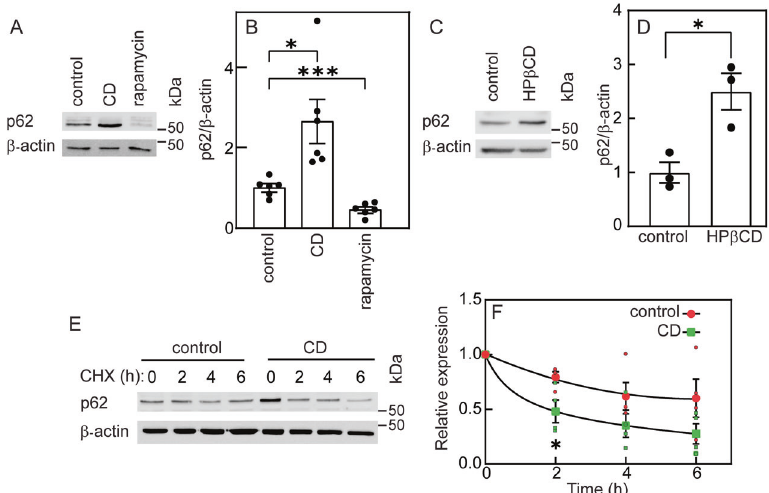
Fig. 4 p62 expression level is increased following cholesterol depletion. Mv1Lu cells were grown and treated (or not) by statin or by HP β CD to induce CD as in Fig. 3, or treated with rapamycin (150 nM, 16 h). They were then lysed and analyzed by immunoblotting for p62 and β -actin (loading control). A , C Representative blots of the effects of statin-mediated CD and of rapamycin ( A ), or of HP β CD-induced CD, on p62 levels ( C ). B , D Quanti fi cation of p62 levels relative to β -actin. The level of p62 in the control sample for each blot was taken as 1. Bars are mean ± SEM of 6 ( B ) or 3 ( D ) independent experiments. Both CD treatments induced a signi fi cant increase in the p62 level relative to untreated cells, while rapamycin reduced the p62 level (* P < 0.05; *** P < 0.001; Student ’ s two-tailed t -test). E A representative blot of p62 degradation. Cells were subjected (or not) to statin-mediated CD, serum-starved (2 h), and subjected to CHX-chase degradation assay ( “ Materials and methods ” ). Note that the zero time point of CHX addition is after 16 h of CD treatment. F Quanti fi cation of p62 degradation (mean ± SEM, n = 4 independent experiments). Data were normalized to β -actin, taking the zero time (prior to CHX addition) for each experimental condition as 1. The degradation rate of p62 was signi fi cantly enhanced following CD (* P < 0.05, Student ’ s two-tailed t -test, comparing between control and CD samples at the same time point).